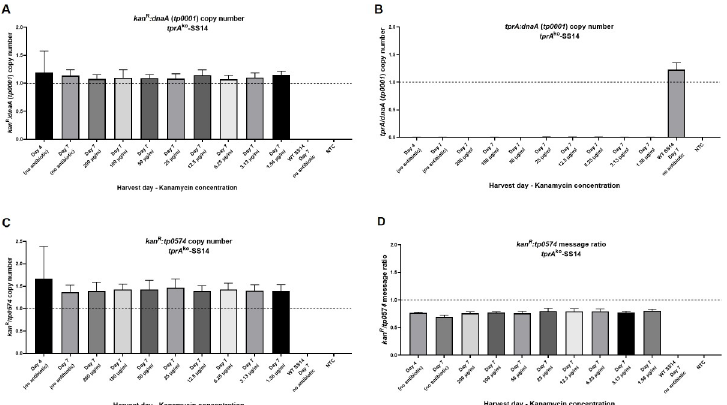
Fig 6. Droplet digital PCR (ddPCR) on DNA or cDNA template from the tprA ko - and wt- SS14 strain propagated in different kanamycin concentrations ( tprA ko -SS14) or no antibiotic (wt-SS14). ( A ) kan R : dnaA gene copy number ratio. ( B ) tprA : dnaA gene copy number ratio. ( C ) kan R / tp0574 gene copy number ratio. ( D ) kan R : tp0574 mRNA ratio. NTC: no template